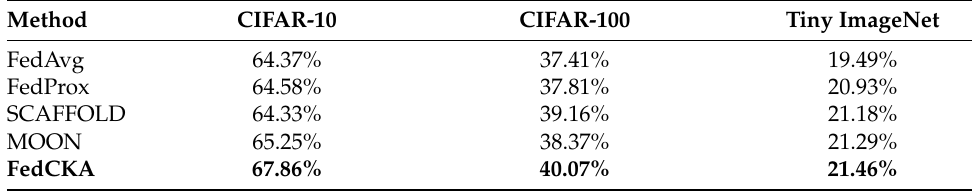
Table 1. Accuracy across datasets ( α = 5.0).